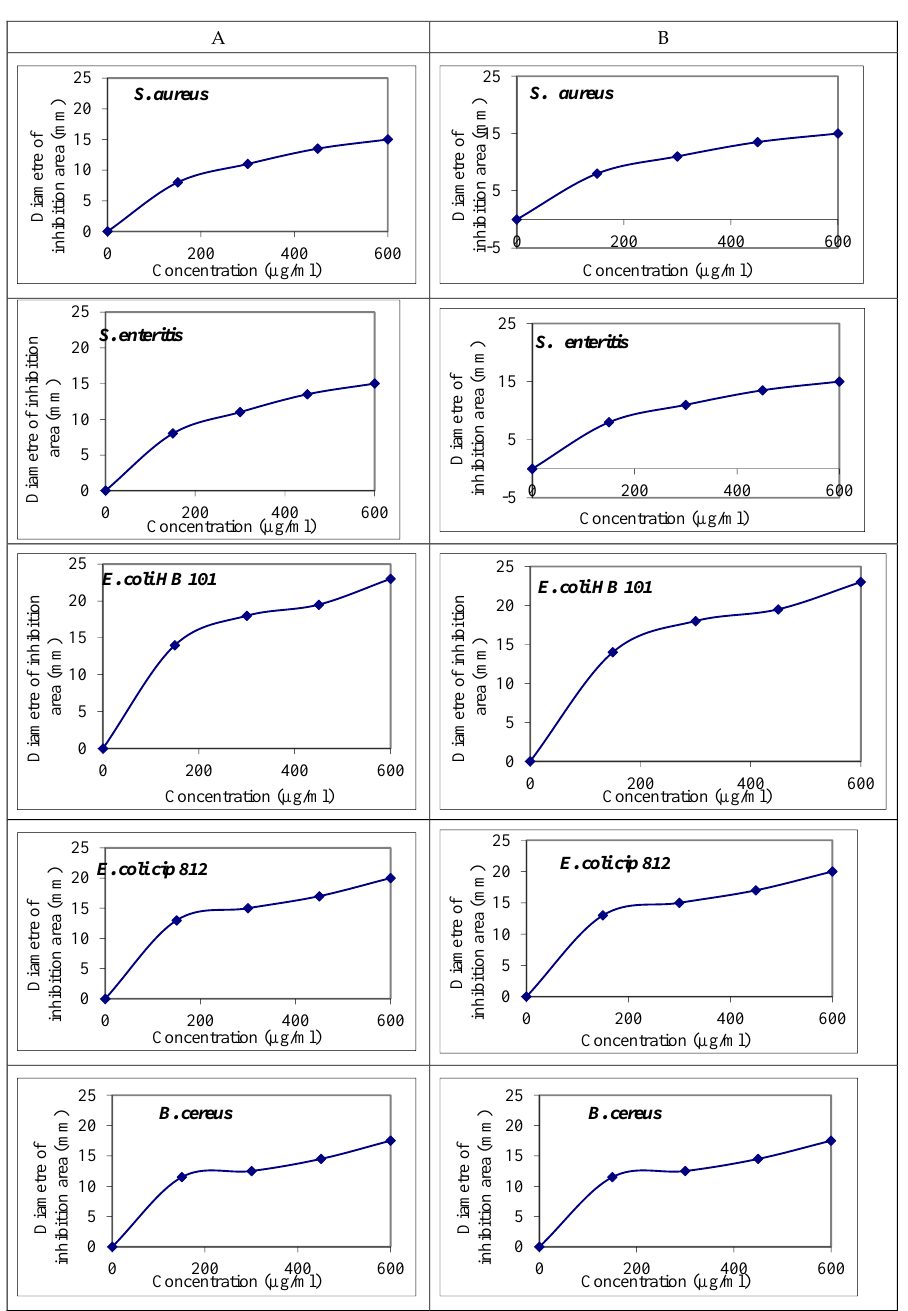
Figure 2. Relative antibacterial activity of Berberis vulgaris roots ( A ) and leaf ( B ) extracts against common food-borne pathogenic